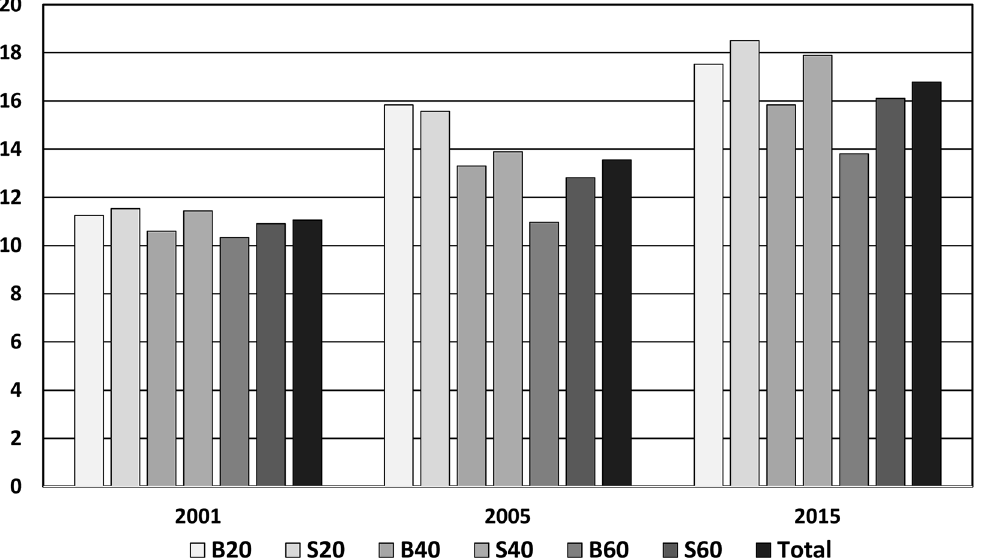
Figure 5. The fragmentation of media use in 2001-2015. The definitions of the six groups: B = basic education or less, and S = secondary education or more; 20: 15-29 yrs. 40: 30-49 yrs, and 60: 50-75 yrs.